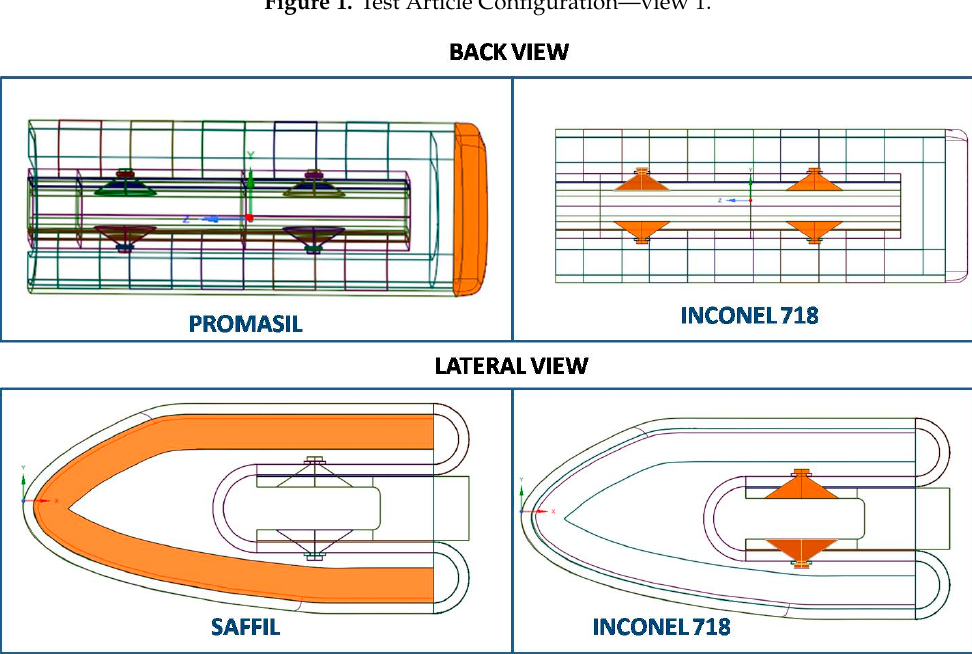
Figure 2. Test Article Configuration – view 2.